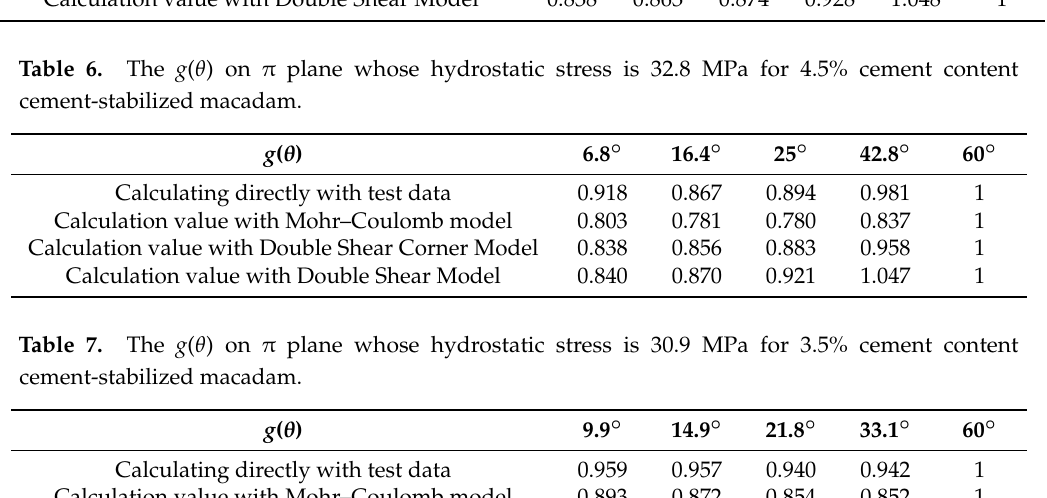
Calculating directly with test data Calculation value with Mohr–Coulomb model Calculation value with Double Shear Corner Model